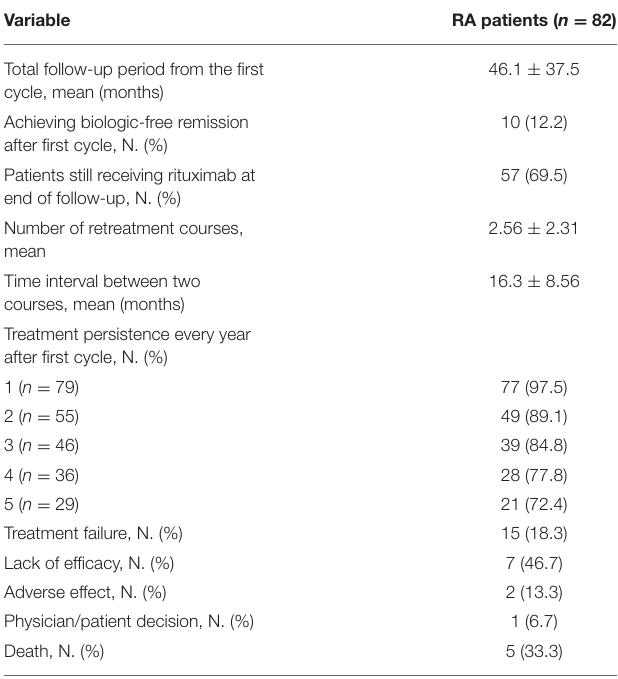
TABLE 2 | Treatment outcome of rituximab in patients with RA. Variable RA patients ( n =